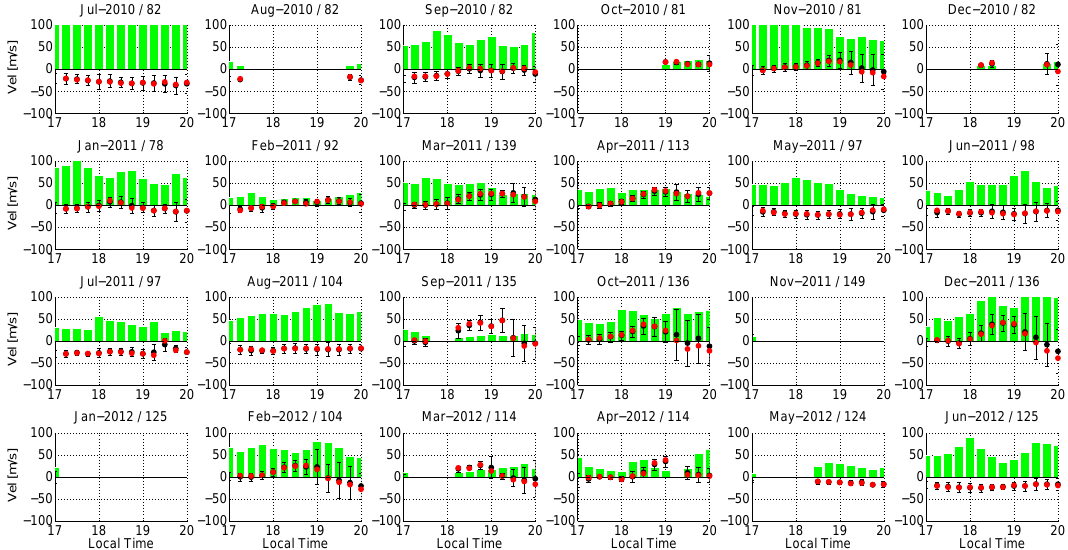
Figure 2. Monthly averages of quiet-time vertical plasma drift measured by C/NOFS near the São Luis site. The green bars indicate the number of measurements available (divided by 10) for each 15min time bin. The black and red markers are results of regular arithmetic mean and median, respectively. The error bars represent the standard deviation of the